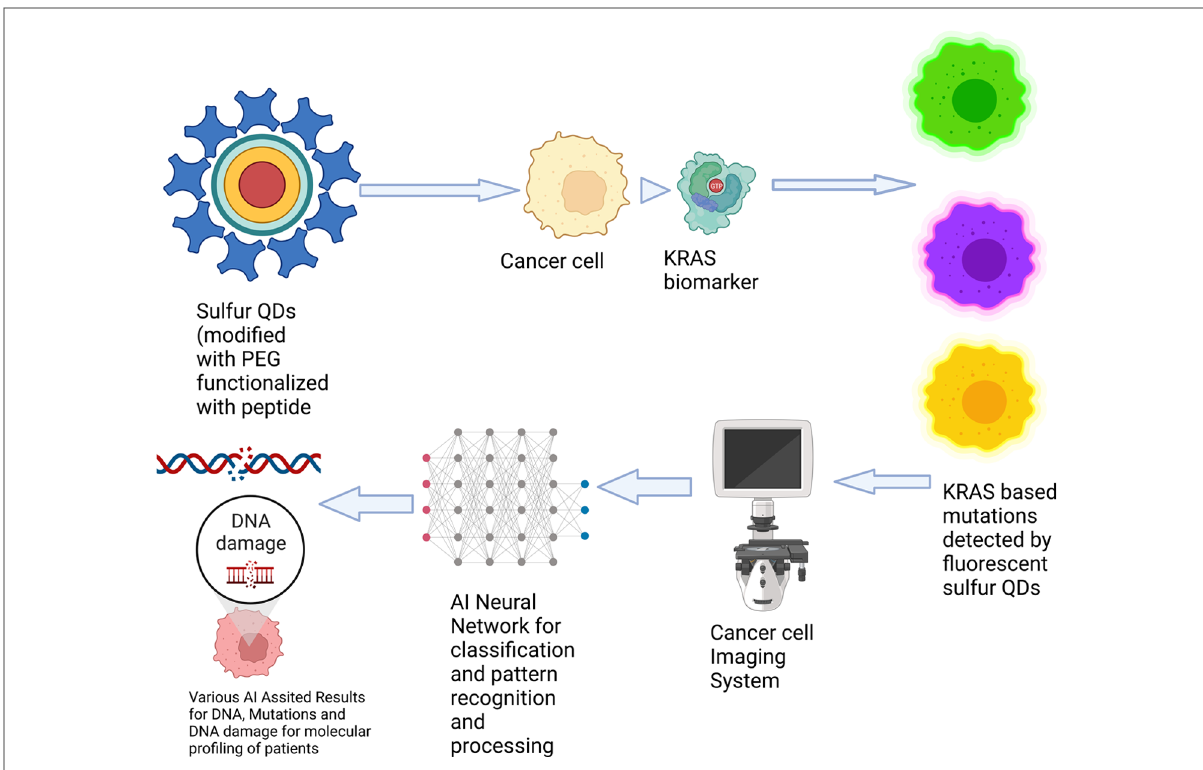
FIGURE 3 Graphical representation of a potential AI-enabled biomarker sensing approach. (Reprinted from “ Nanoparticle-Mediated Targeted Drug Delivery to Cancer Stem Cells ” , by BioRender, June